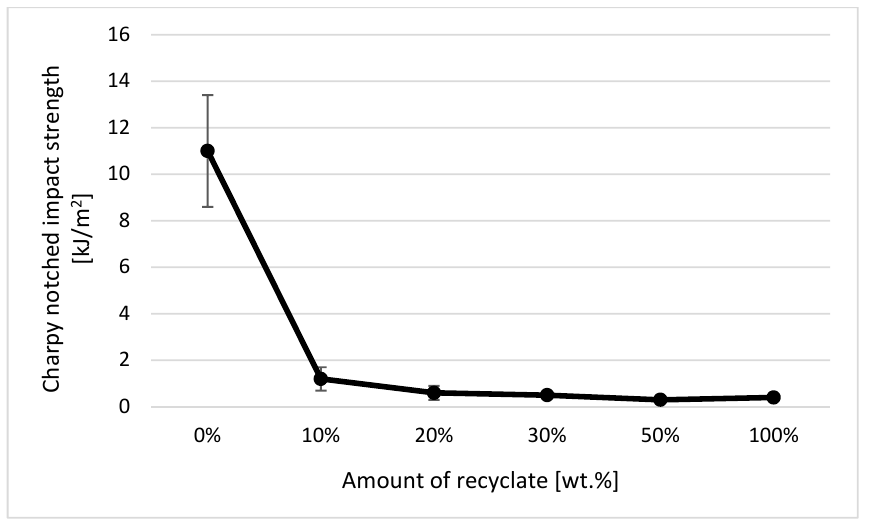
Figure 22. Dependence of the notched strength on the amount of the recycled material after exposure of the samples to elevated temperature.